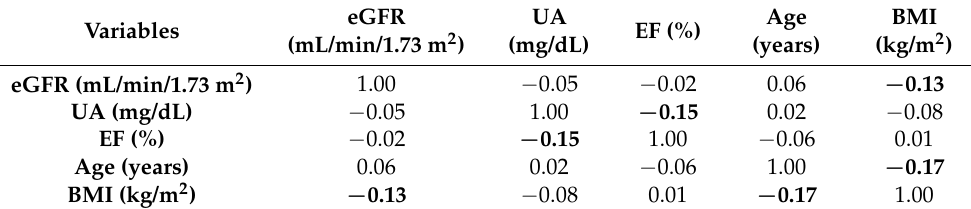
Table 5. Results of correlation analysis for patients that used diuretics. Age BMI eGFR UA EF (%) Variables (years) (kg/m 2 ) (mL/min/1.73 m 2 ) (mg/dL) eGFR (mL/min/1.73 m 2 ) 1.00 − 0.05 − 0.02 0.06 − 0.13 UA (mg/dL) − 0.05 1.00 − 0.15 0.02 − 0.08 EF (%) − 0.02 − 0.15 1.00 − 0.06 0.01 Age (years) 0.06 0.02 − 0.06 1.00 − 0.17 BMI (kg/m 2 ) − 0.13 − 0.08 0.01 − 0.17